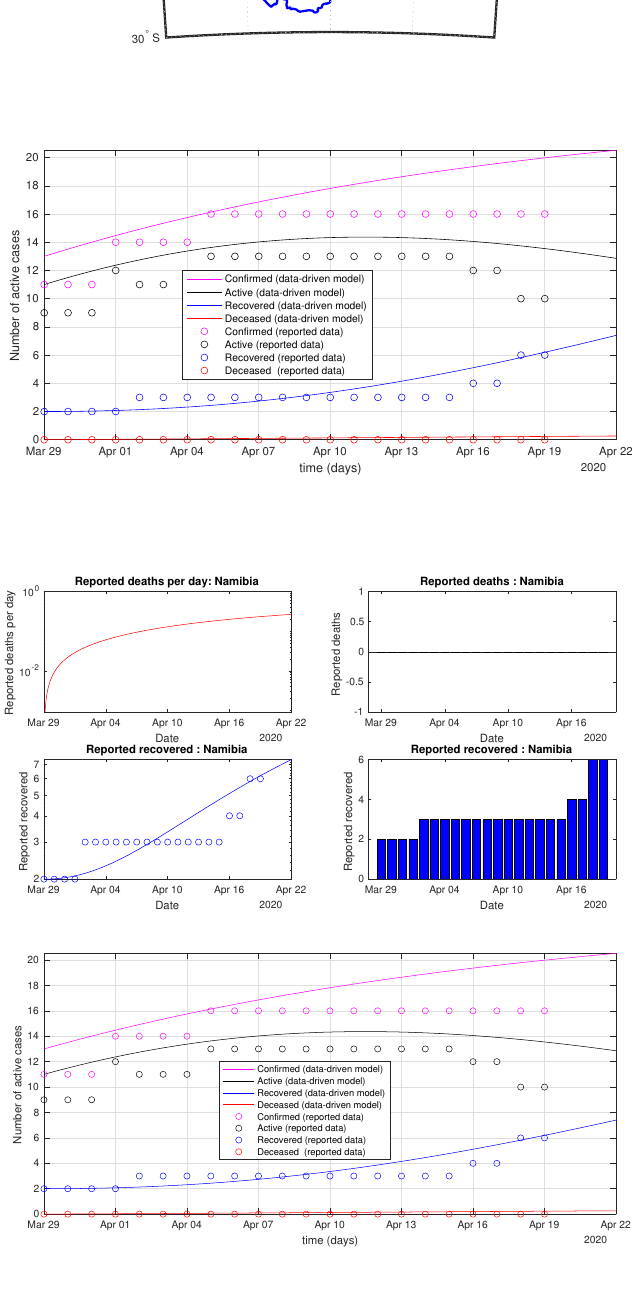
Figure 77. Namibia: data vs.